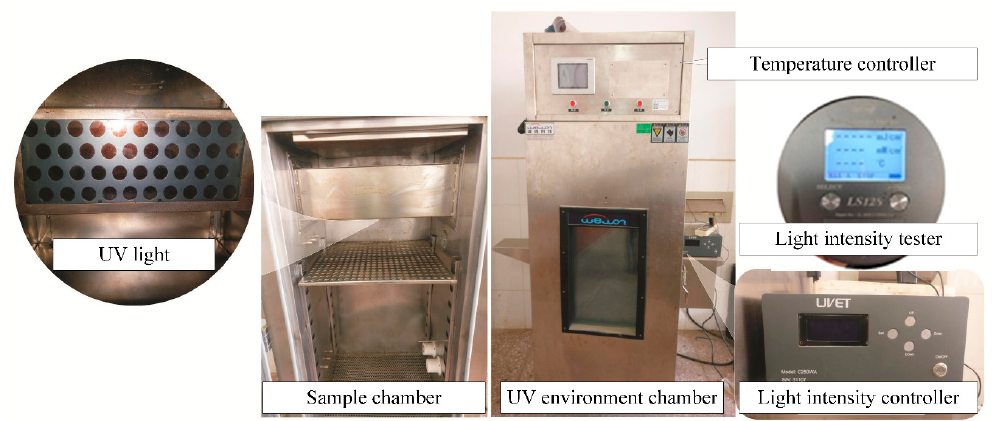
Figure 1. Self-made UV environment apparatus.